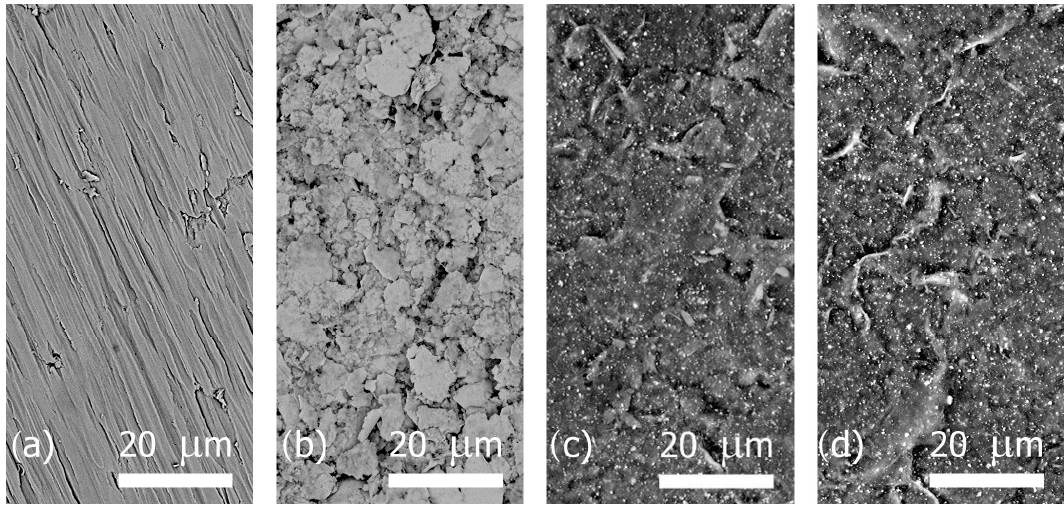
Figure 4. SEM images of surfaces of ( a ) Cu, ( b ) AGS, ( c ) CMD, and ( d ) CSP sensing elements. Table 1. The measured characteristics of soil moisture sensor layers.